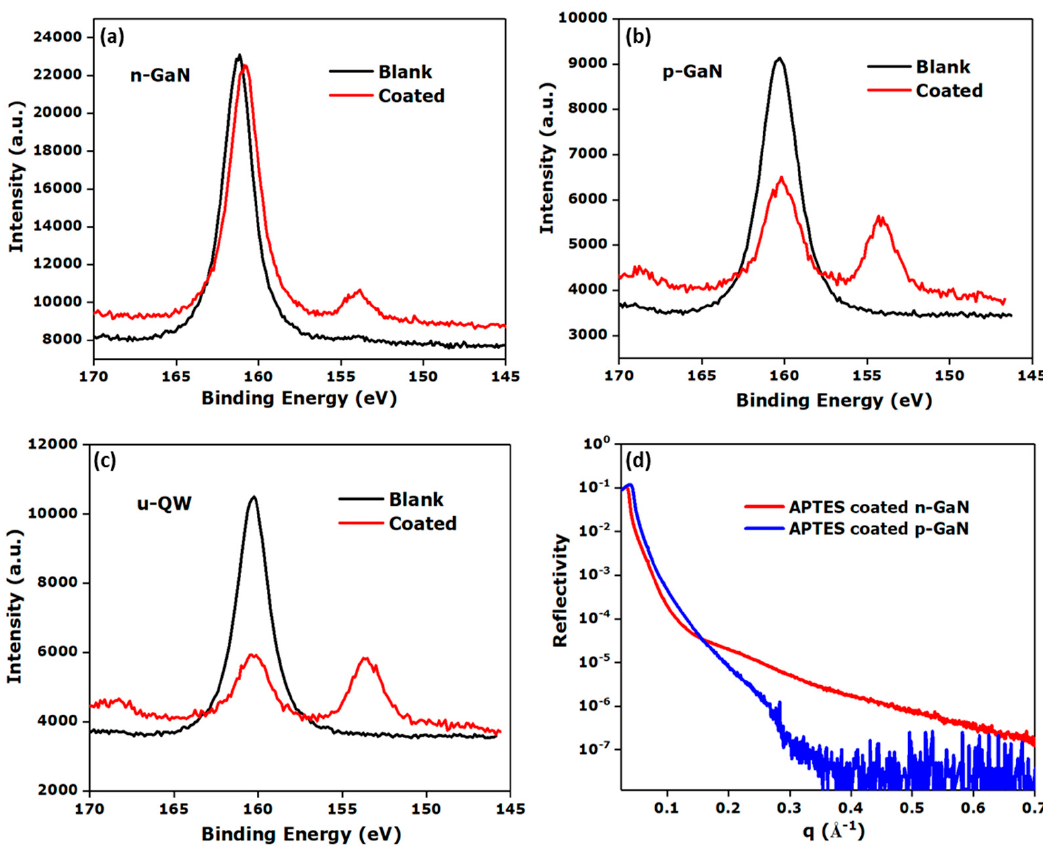
Figure 4. Si (2s) XP spectra of bare and APTES-coated ( a ) Si-doped GaN (n-GaN, B ), ( b ) Mg-doped GaN (p-GaN, A ) and ( c ) undoped QW (u-QW, D ). ( d ) X-ray reflectivity (XRR) pattern of APTES-coated n-GaN (red) ( B ) and p-GaN (blue) ( A ), x-axis: Scattering vector (q).